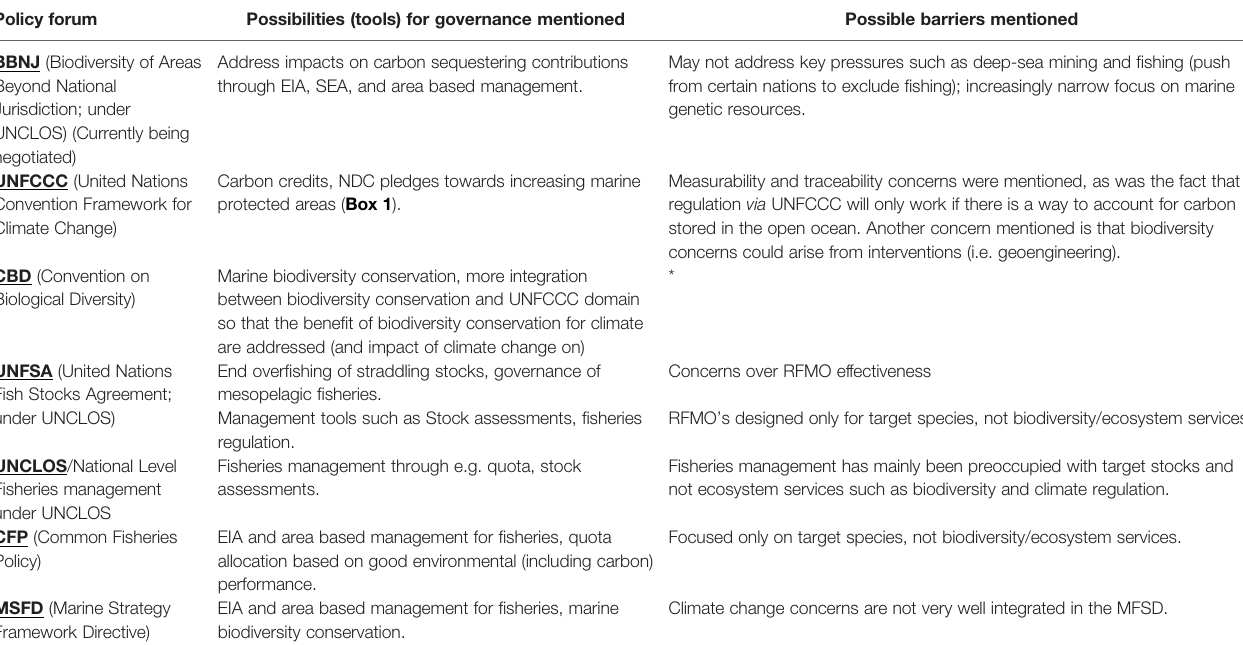
TABLE 2 | Interviewee re fl ections on potential policy fora, their possibilities for governance of open ocean and fi sh carbon sequestration services, possible barriers and concrete tools for management.